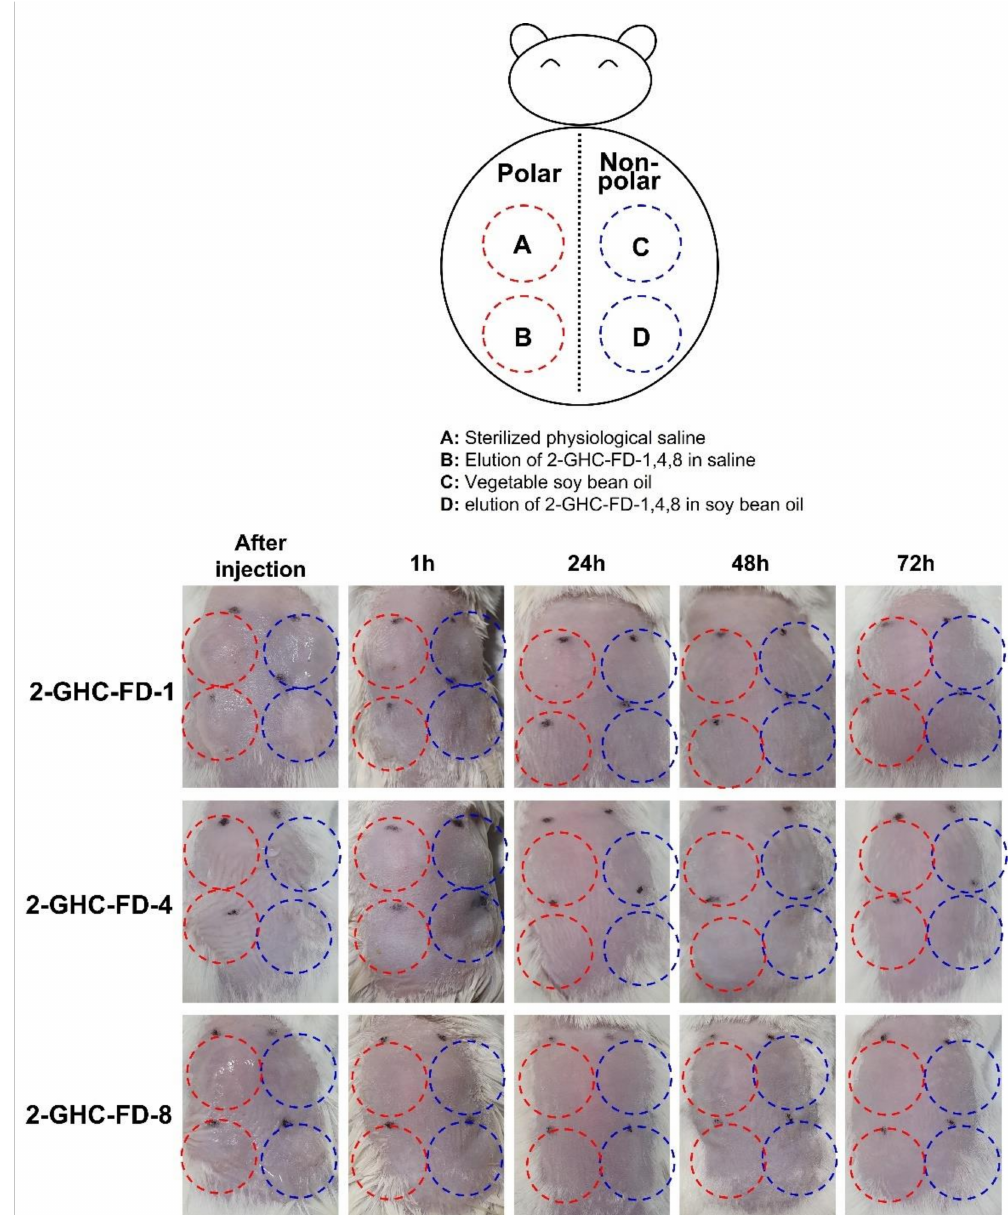
Figure 5. Macroscopic appearances of backs of mice injected with elution from 2-GHC-FD-1, 2-GHC-FD-4, and 2-GHC- FD-8. This test was performed for 1, 24, 48, and 72 h after injection. Red dotted circles–( A ) sterilized physiological saline; ( B ) elution of 2-GHC-FD-1,4,8 saline. Sky blue dotted circles–( C ) vegetable soy bean oil; ( D ) elution of 2-GHC-FD-1,4,8 in soy bean oil. The black points indicate injection